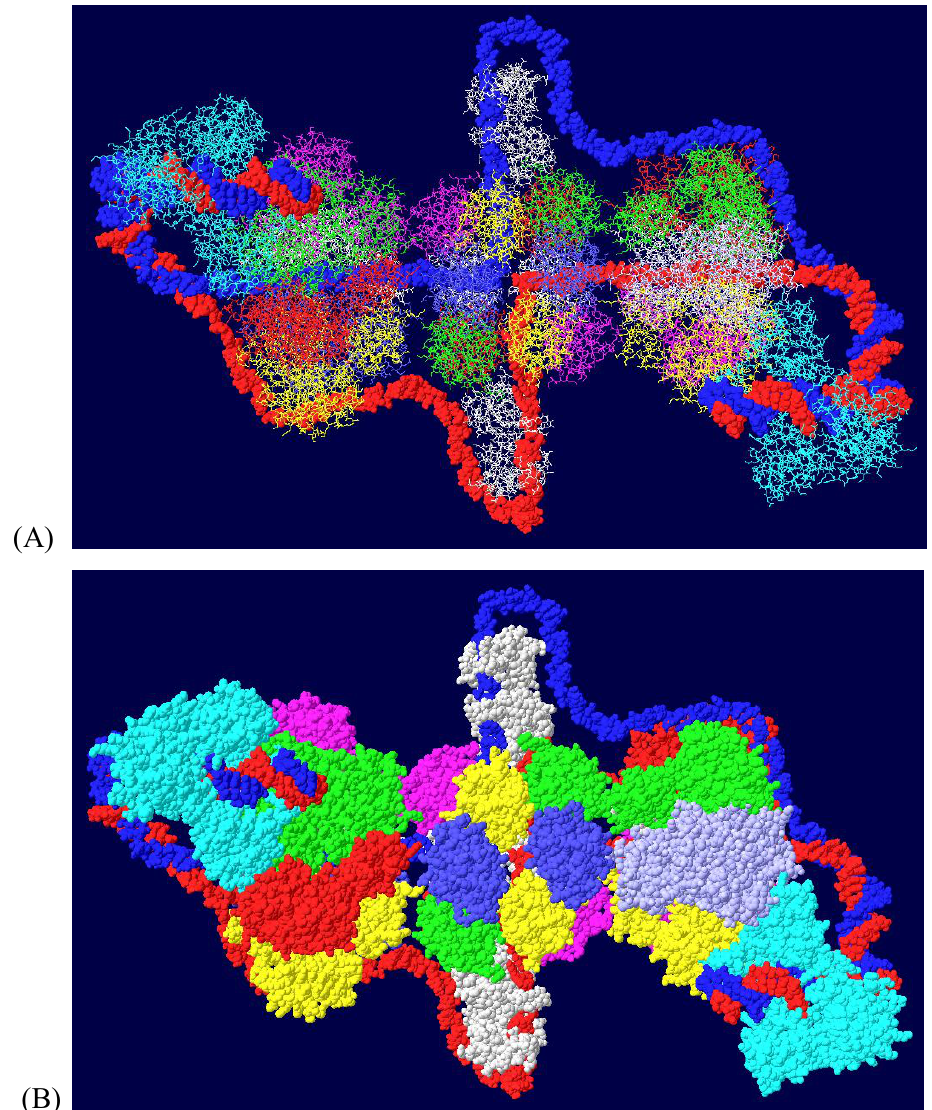
Figure 7. Complete model of DNA threading through DH with associated RPA and C-terminal bound topo I. Topo I (shown in cyan) was fitted on the back end of each helicase where it interacts with residues near the C-terminal end of T antigen. Double stranded DNA is shown going through topo I (present in original structure), bend, and separate into its two strands, one going through the central channel of the helicase and one going around. ( A ) Representation of the 3D structure with only the DNA shown space filled. ( B ) Space filled representation of entire